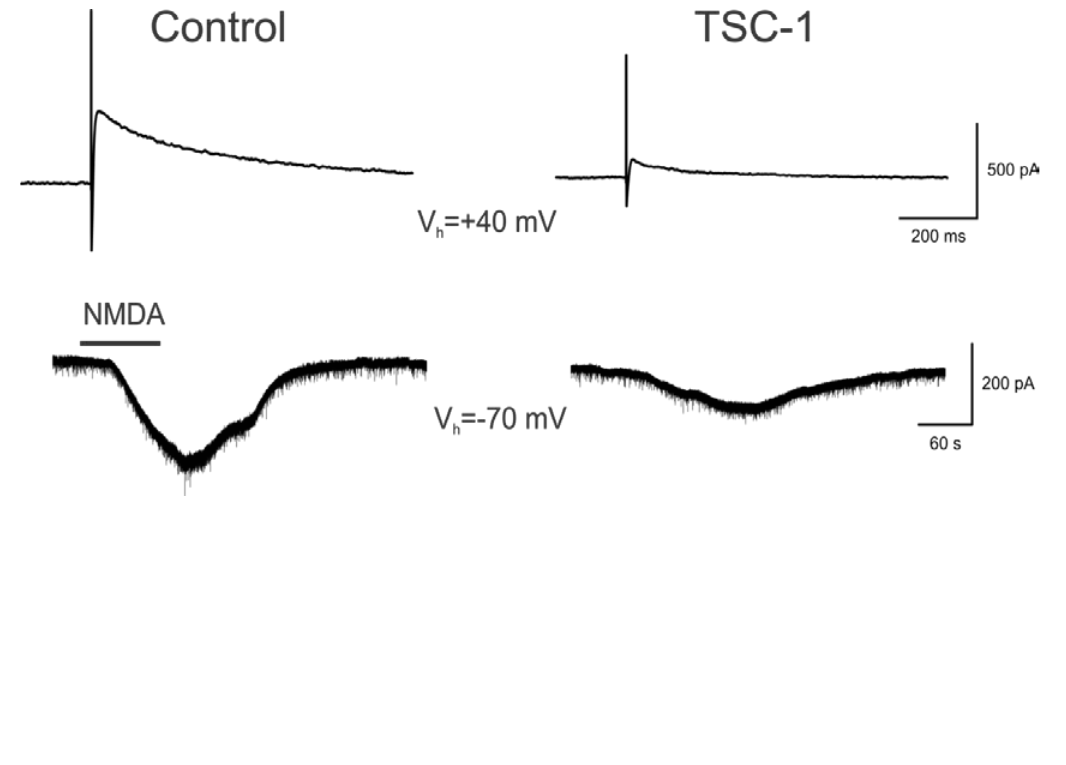
Figure 5. Neuroprotection of Medium-sized Spiny Neurons (MSNs). Upper traces represent responses of striatal MSNs evoked by electrical stimulation (0.2 mA, 0.1 ms duration) of cortical inputs. Recordings were obtained with patch electrodes in voltage clamp mode (holding voltage at +40 mV). Control trace is a NMDA receptor-mediated response recorded in normal ACSF solution and isolated pharmacologically by adding 2,3-dihydroxy-6-nitro-7-sulfamoyl-benzo[ f ]quinoxaline-2,3-dione (NBQX, 10 μM) and Bicuculline (10 μM). The trace on the right is from another cell recorded after the slice was incubated for 1 h in TSC1 solution (2 μL/mL). Lower traces show responses to bath application of NMDA (100 μM) in ACSF (left) or after incubation for 1 h in TSC-1. Notice that the NMDA responses were significantly reduced compared to control conditions. Calibration bars apply to both